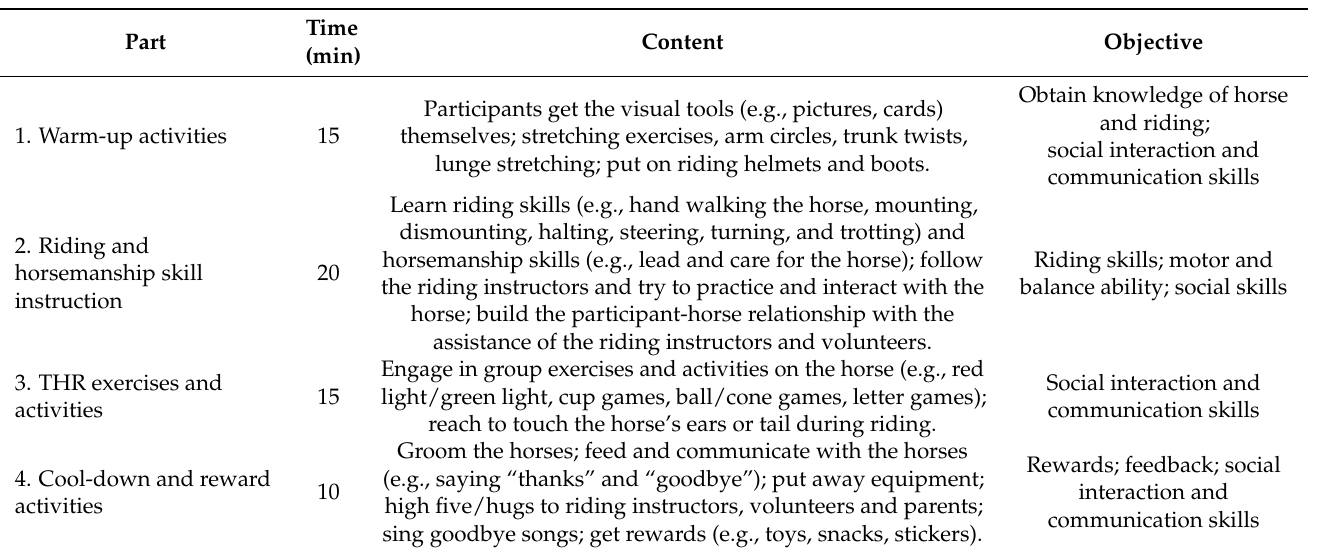
Table 2. THR intervention program protocol.